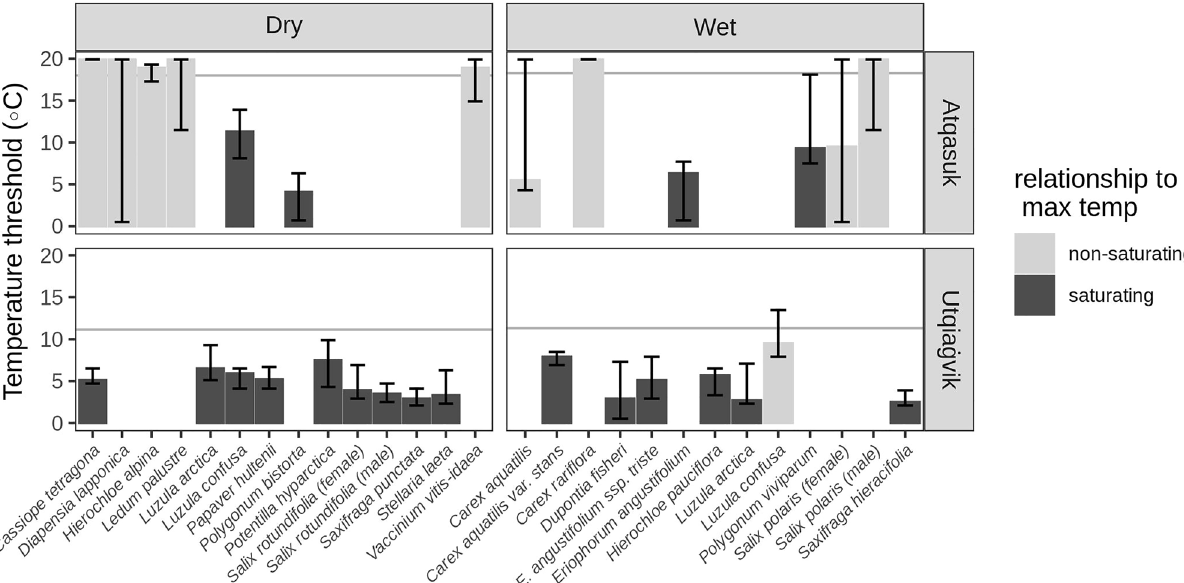
Figure 3. Estimated maximum temperature thresholds of tundra plants. Thresholds were estimated as the lowest AIC values when comparing generalized additive mixed models of GDD max (calculated from 0 to 20 °C) with flower counts of the plants growing in ambient conditions observed at each location. The height of bars indicates the median estimated threshold after refitting the models omitting a single year in each iteration; error bars show range (min and max). A dark fill color indicates that the species showed a saturating phenological response to increasing temperature (where accounting for higher temperatures decreases the quality of the model) and show evidence for a maximum threshold within the range of temperatures commonly observed (see Supplemental Fig. 2 for individual fits). A light fill color indicates a lack of consistent evidence for a maximum threshold within the range of temperatures commonly observed. Below the horizontal line represents 95% of the observed hourly summer air temperatures at the